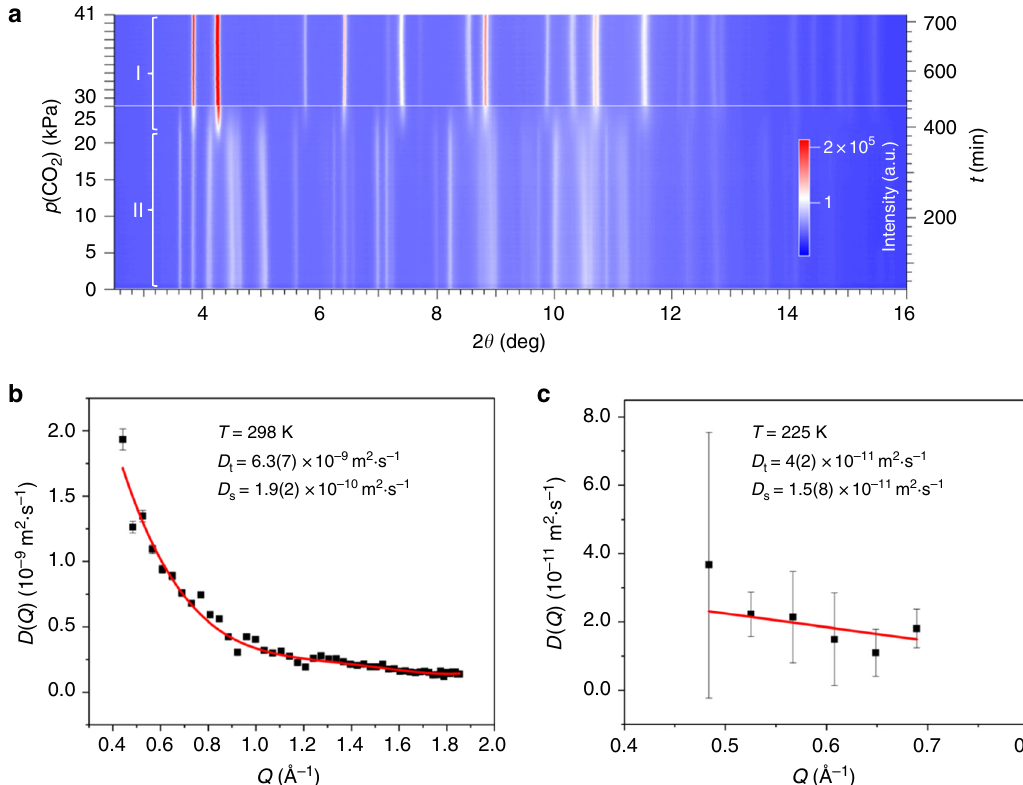
Fig. 2 Phase transition and CO 2 diffusion in ZIF-7. a In situ SXRD data of ZIF-7 at T = 195 K, p (CO 2 ) = 0 – 41 kPa. λ = 0.82634(1) Å. At 0 – 23 kPa, the diffraction pattern corresponds to ZIF-7-II. Above 30 kPa, the diffraction pattern of ZIF-7-I dominates. b The Q dependence of the CO 2 transport diffusion coef fi cient D in ZIF-7 at a CO 2 loading of 1.3 mmol g − 1 and T = 298 K, fi tted by a 4th-order polynomial function. Error bars are calculated using Supplementary Equation 6. D t : transport diffusivity. D t = D (0). D s : self-diffusivity. D t = D s ( ∂ ln p / ∂ ln c ). p is CO 2 pressure in kPa and c is CO 2 uptake at p in mmolg − 1 . See Supplementary Discussion for detailed analysis. c The Q dependence of the CO 2 transport diffusion coef fi cient D in ZIF-7 at a CO 2 loading of 1.3 mmol g − 1 and T = 225 K, fi tted by a linear function. Error bars are calculated using Supplementary Equation